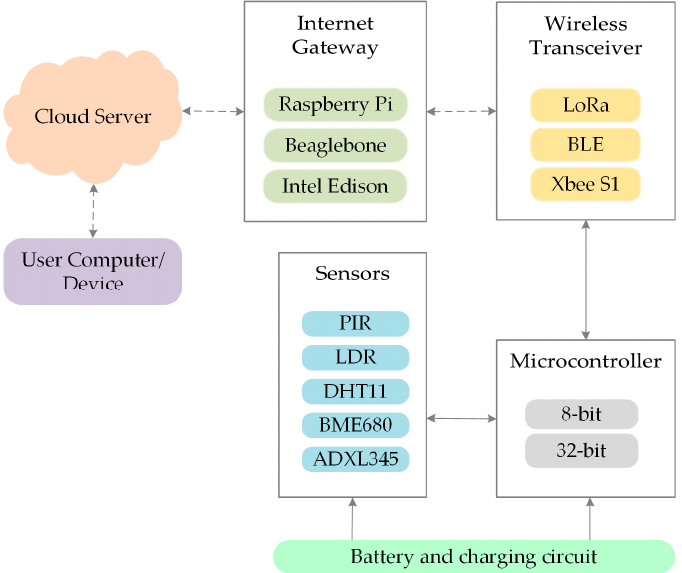
Figure 2. Modular LiB architecture.